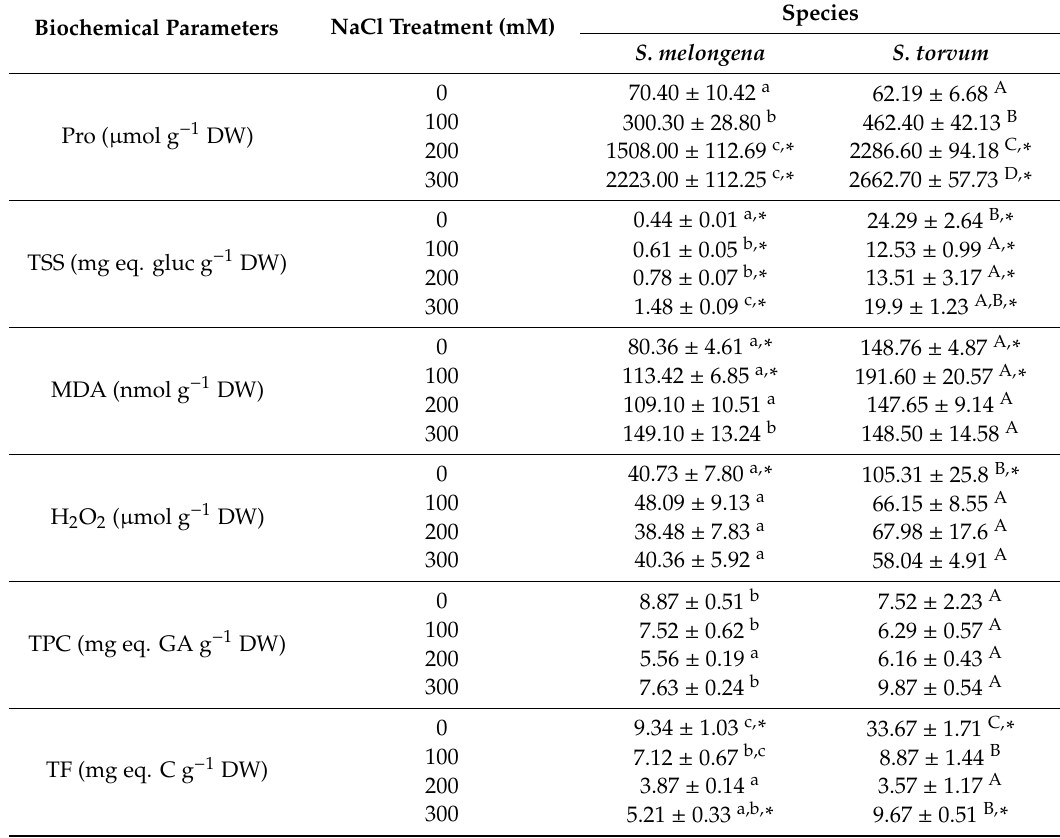
Table 7. Proline (Pro), total soluble sugars (TSS), malondialdehyde (MDA), hydrogen peroxide (H 2 O 2 ), total phenolic compounds (TPC), and total flavonoids (TF) leaf contents (mean ± SE, n = 5) in Solanum melongena and S. torvum plants after 25 days of salt treatments with the indicated NaCl